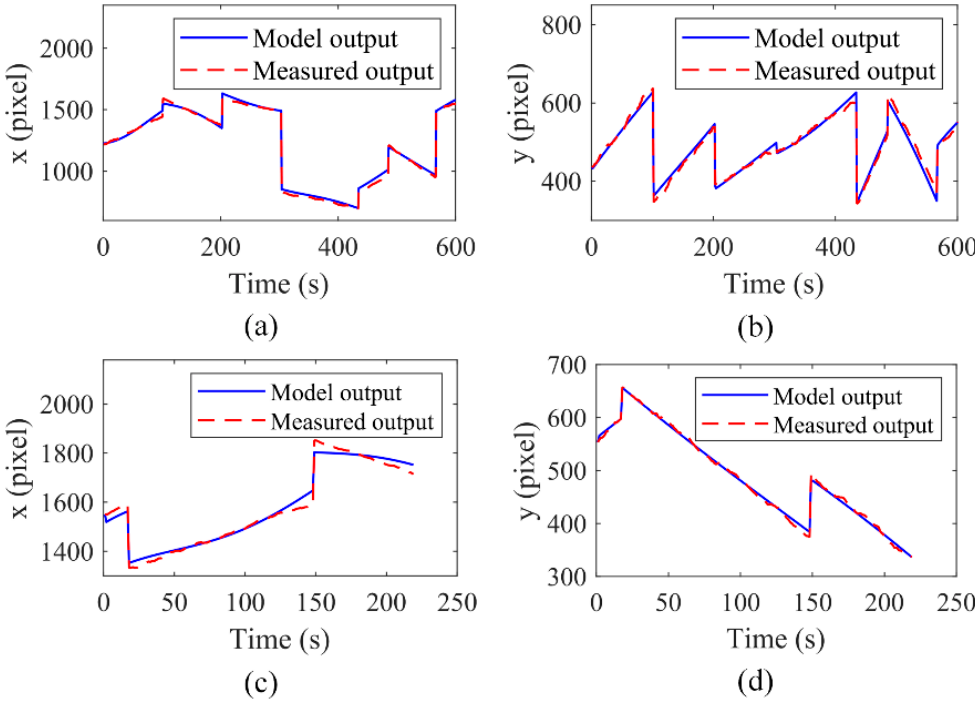
Figure 3. The model output and the measured output with the datasets for modeling at the x-axis ( a ) and the y-axis ( b ), respectively; The model output and the measured output with the data sets for validating the model at the x-axis ( c ) and the y-axis ( d ), respectively.